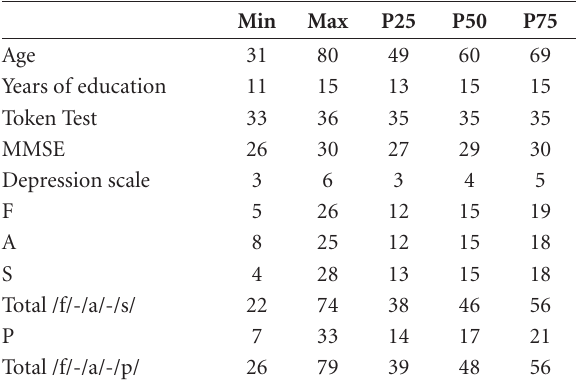
Table 1. Descriptive statistics of the sample (n=48)